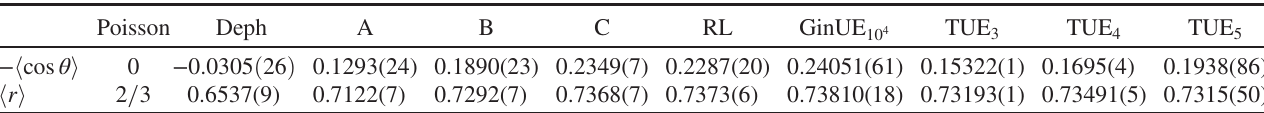
TABLE I. Single-number signatures of integrability or chaos for different Liouvillians: models Deph, A, B, C, and RL. They are compared with exact analytical results for uncorrelated random variables (labeled Poisson), numerical exact diagonalization of ( 10 4 × 10 4 ) random GinUE matrices, and TUE surmise estimates for N ¼ 3 , 4, 5 (subscripts denote matrix size) computed from Eq. (C9). The convergence of h cos θ i computed from the TUE surmises is much slower than that of h r i , as noted in the text. Poisson Deph A